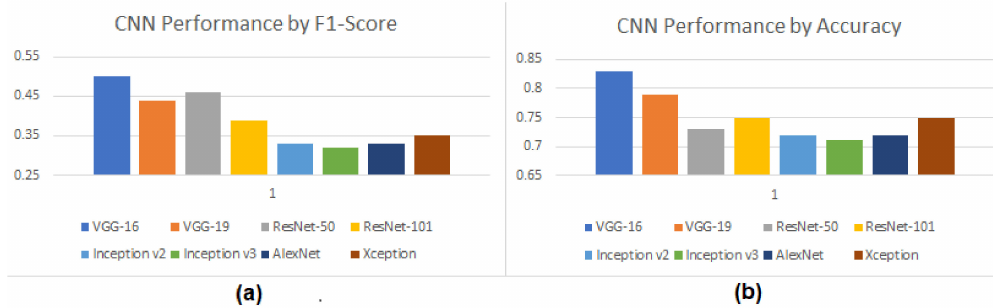
Figure 8. Results of CNN Image Classification testing by ( a ) F1-Score and ( b ) Accuracy, 60/40 Split.